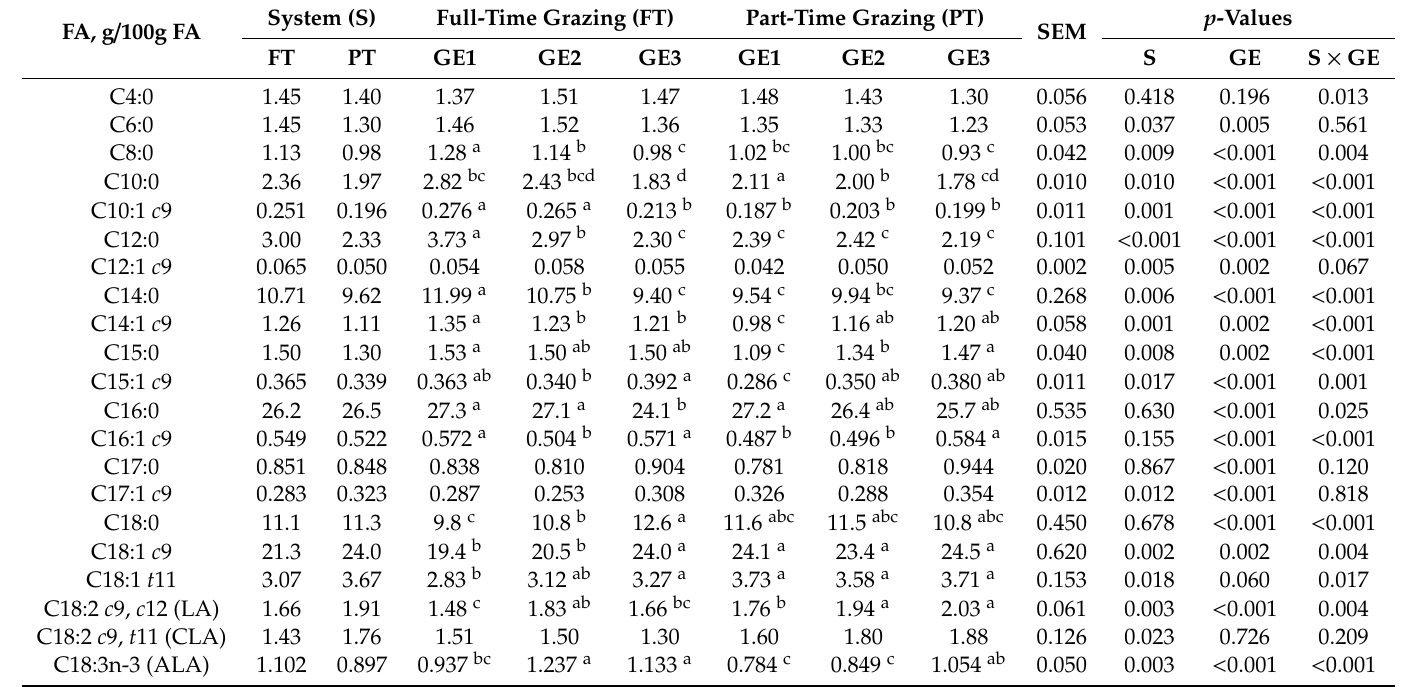
Table 5. Least square means of proportions of selected 1 individual milk FA in the two pasture management systems and the three GEs. System (S) Full-Time Grazing FA, g / 100g FA